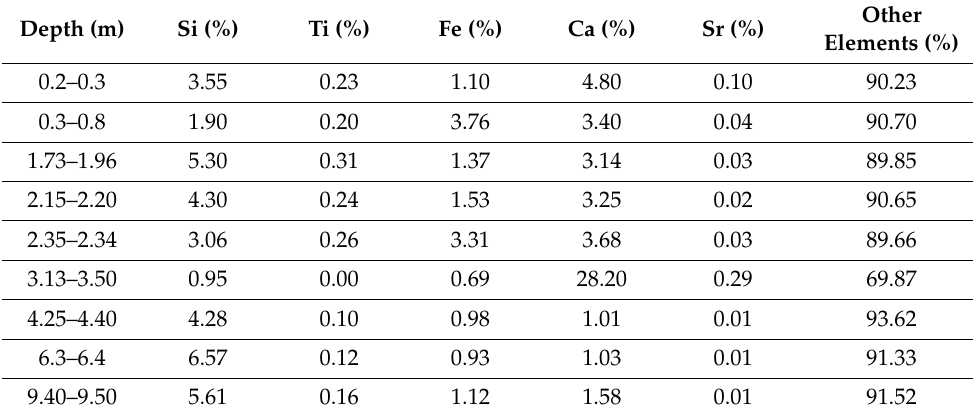
Table 1. Rybachya core geochemical analysis